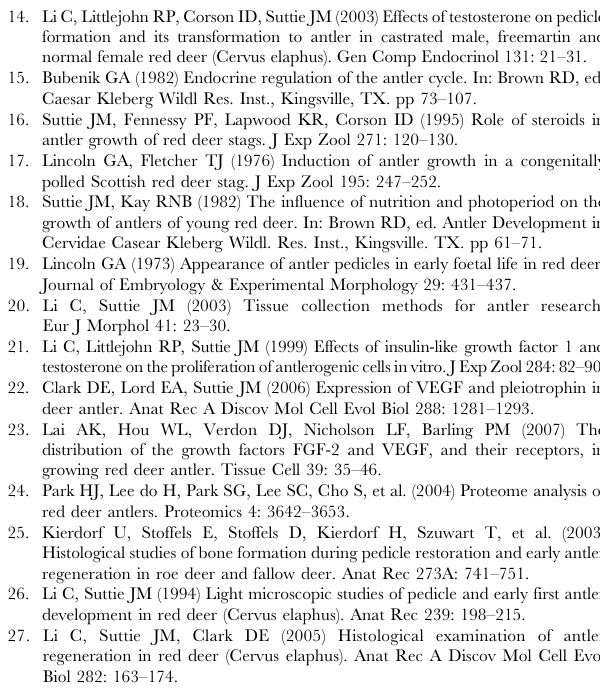
Figure S1 Pedicle periosteum (PP) and antlerogenic periosteum (AP). A: PP deletion. PP was peeled off from a pedicle stump after being cut into strips (arrow). B: PP-less pedicle failed to give rise to a regenerating antler (arrow), although the control pedicle formed a two-tine antler. C: AP deletion. AP was peeled off from the future pedicle growth region prior to initiation of the pedicle (arrow). D: No pedicle and antler were formed from the AP-less future pedicle growth region, whereas a two-tine ectopic antler was formed from the AP-grafted-forehead-region (arrow). Figure S2 Merged networks of the APC proteome. Note that most of the proteins identified could be linked together